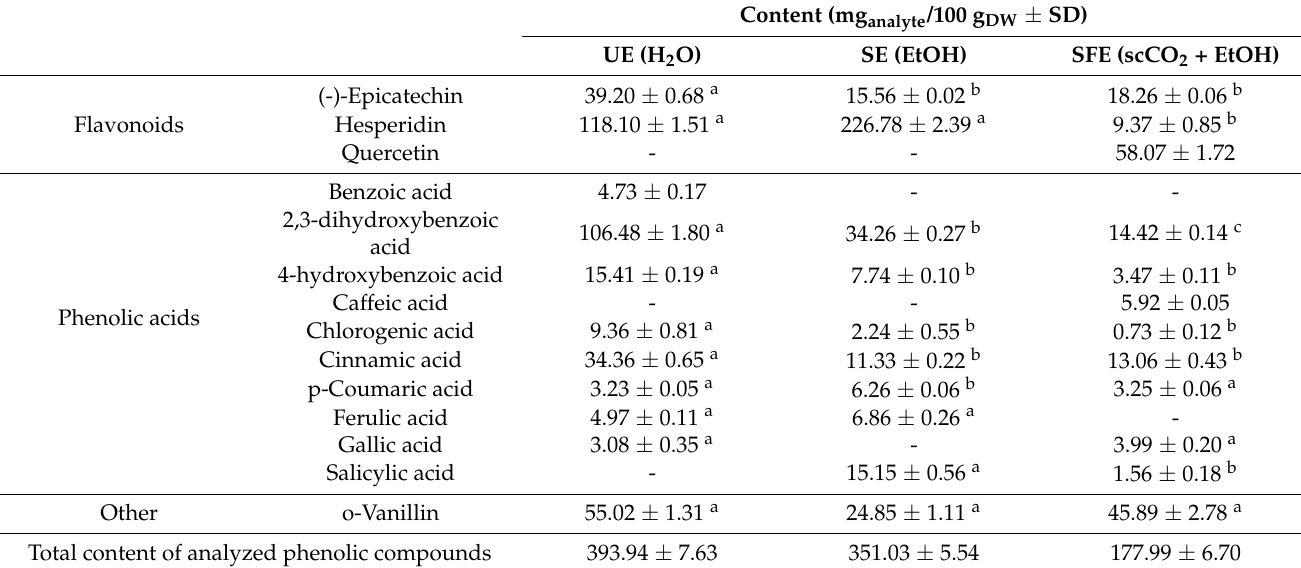
Table 2. Content of certain phenolic compounds in AS extracts obtained by HPLC after ultrasonic extraction (UE; solvent H 2 O), Soxhlet extraction (SE; solvent EtOH), and supercritical fluid extraction (SFE; solvent scCO 2 , co-solvent